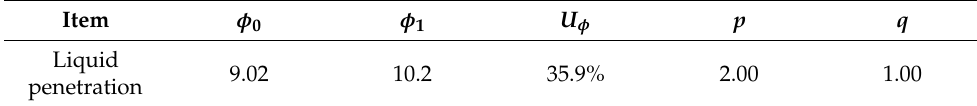
Table 2. Output from the uncertainty estimation